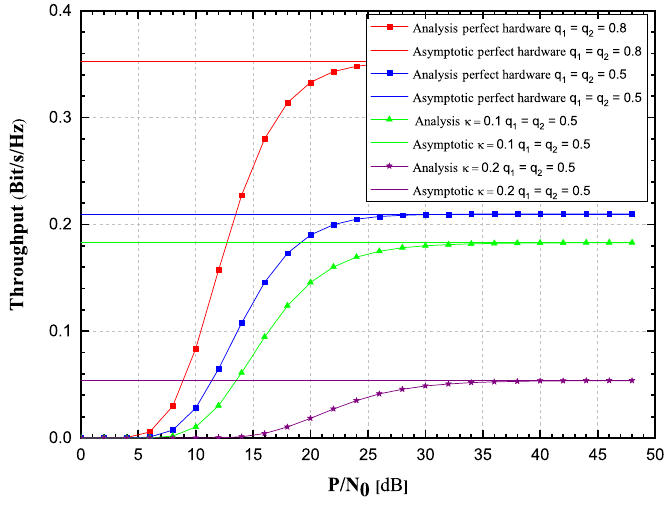
Figure 3. Hoyt fading channels: Achievable throughput versus P / N 0 , 2019 IEEE